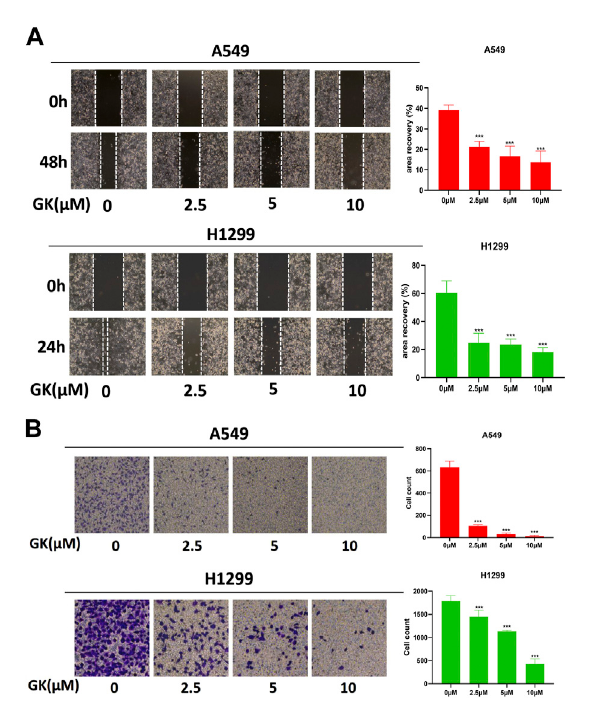
FIGURE 9 GK represses metastasis of A549 and H1299 cells in vitro . (A) Migration of A549 and H1299 cells, treated as indicated, was analyzed in wound-healing assays. (B) Transwell assay was used to assess the effect of GK on cell migration (magni fi cation ×100).